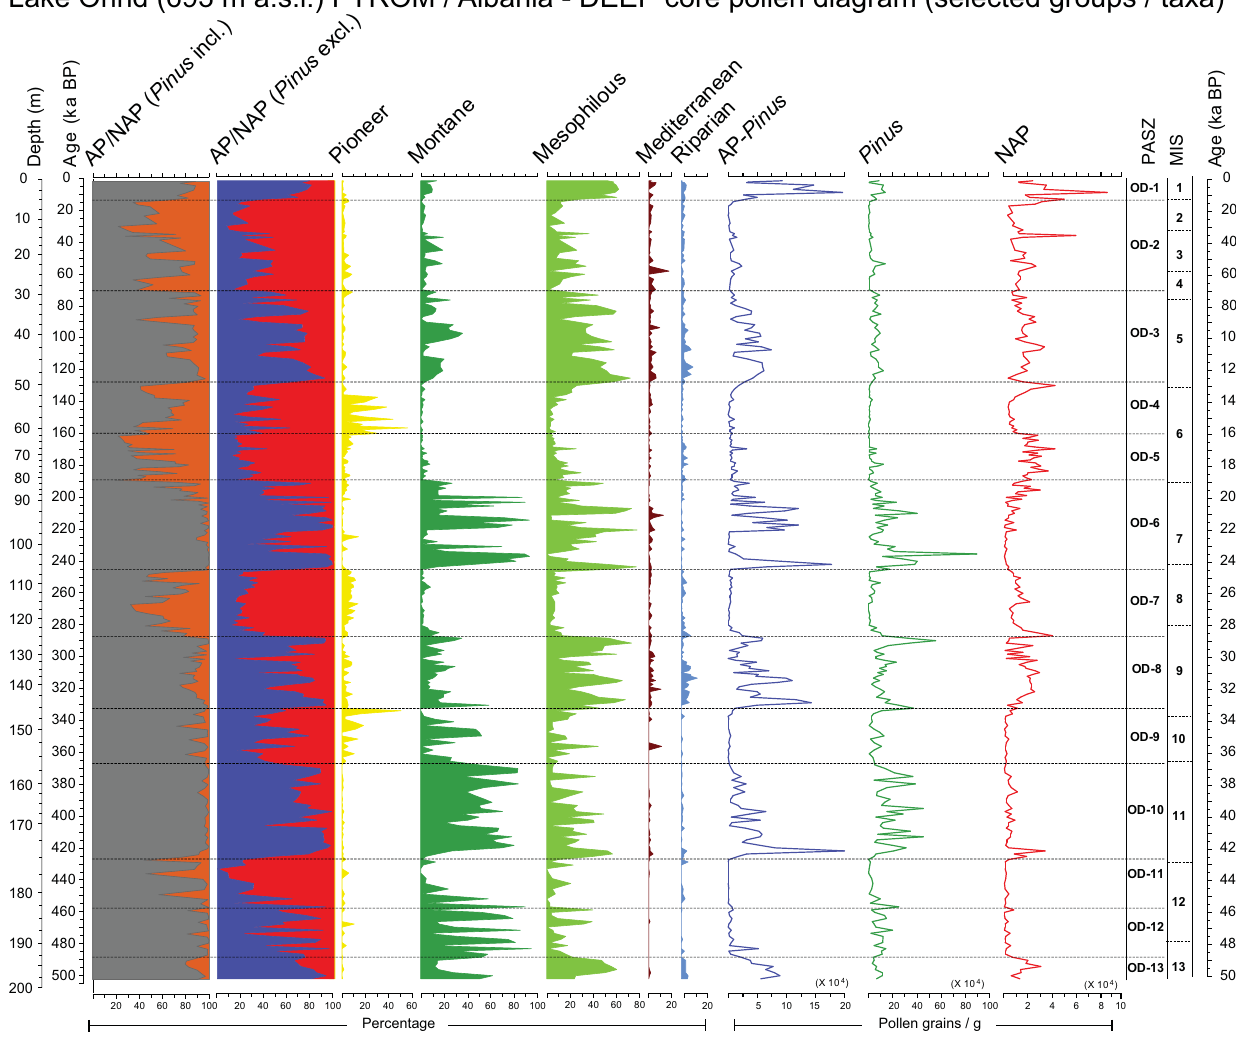
Figure 3. Lake Ohrid (FYROM), DEEP core. Pollen diagram of selected ecological groups (%) and concentration curves against chronology (Francke et al., 2016). Ecological groups: montane trees ( Abies , Betula , Fagus , Ilex , Picea , Taxus ); mesophilous trees ( Acer , Buxus , Carpinus betulus , Castanea , Carya , Celtis , Corylus , Fraxinus excelsior / oxycarpa , Ostrya / Carpinus orientalis , Pterocarya , Hedera , Quercus robur type, Quercus cerris type, Tilia , Tsuga , Ulmus , Zelkova ); mediterranean trees ( Arbutus , Fraxinus ornus , Cistus , Olea , Phillyrea , Pistacia , Quercus ilex , Rhamnus ); riparian trees ( Salix , Platanus , Populus , Alnus , Tamarix ); pioneer shrubs ( Ephedra , Juniperus type, Ericaceae, Hippophaë